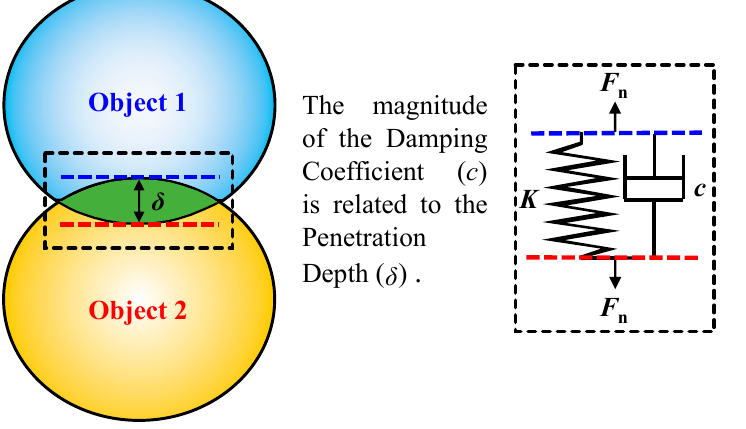
Figure 6. Normal contact force model.